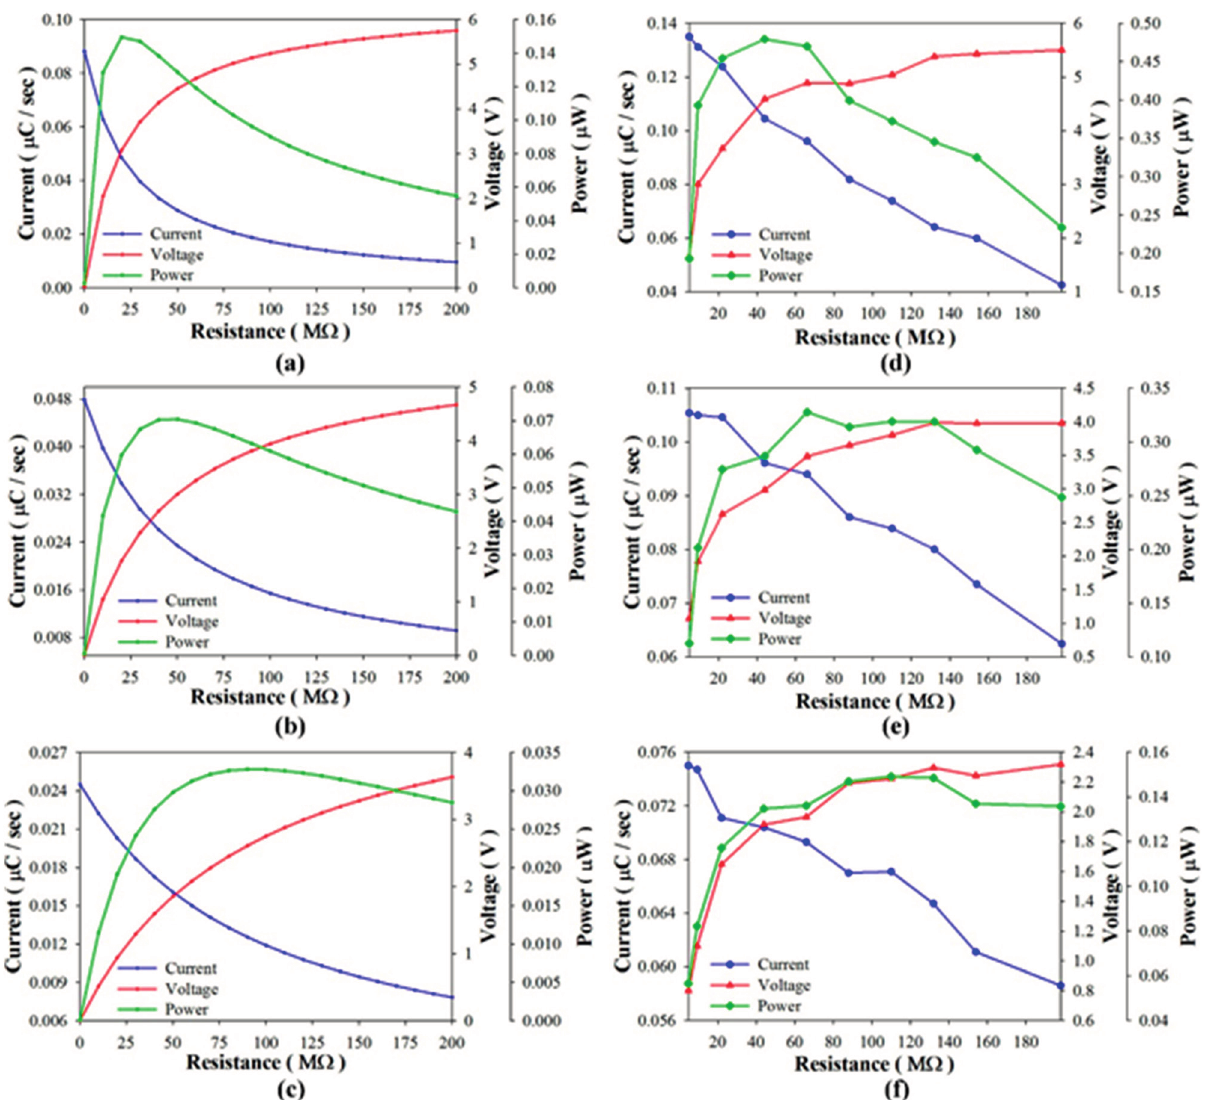
Figure 9. Harvested power, voltage and current as functions of the load resistance when using PZT cells with thicknesses of 100 μ m ( a , d ), 200 μ m ( b , e ), and 400 μ m ( c , f ) at a constant period of 16 s as determined in the simulated calculation ( a – c ) and the experiment ( d – f